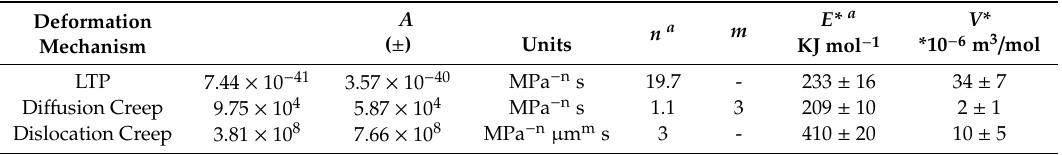
Table 4. Flow law parameters for deformation mechanisms operating in magnesite